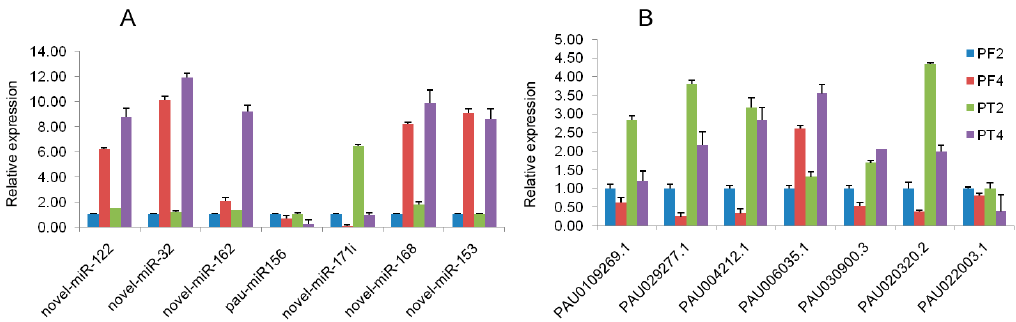
Figure 4. qRT-PCR analysis of transcriptome and miRNA sequencing data. In this figure, ( A ) qRT-PCR analysis of selective miRNAs; ( B ) qPCR analysis of the selective DEGs. PF2: diploid P. fortunei . PF4: tetraploid P. fortunei . PT2: diploid P. tomentosa . PT4: tetraploid P. tomentosa .